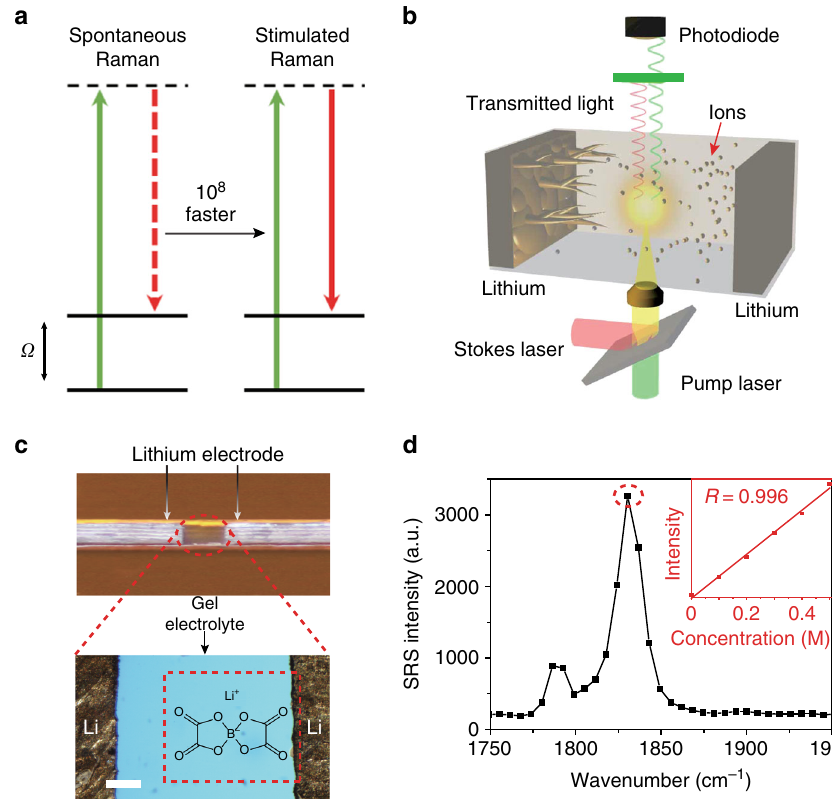
Fig. 1 Experimental principle and design. a Energy diagrams of spontaneous Raman scattering and stimulated Raman scattering (SRS). In spontaneous Raman, only one laser (green, solid line) is used, and the scattered photons (red, dashed line) will have an energy loss of Ω , corresponding to the vibrational energy of the targeted bond. In SRS, two different lasers (green/red, solid line) with energy gaps matching Ω are simultaneously used and yield up to 10 8 times faster vibrational transitions. b A schematic illustration of a Li – Li symmetric cell under SRS imaging. The two lasers are the pump laser and Stokes laser. c A camera image of a Li – Li symmetric cell (top) and zoom-in microscope image (bottom). Scale bar is 100 μ m. The red, dashed rectangle indicates the imaging area. The molecular structure is of the LiBOB salt used in our study. Scale bar is 100 μ m. d The SRS spectrum of 0.5 M LiBOB in TEGDME/PVdF-HFP gel electrolyte. The inset shows the linear concentration dependence between the Raman intensity at 1830 cm – 1 (dashed circle) and the LiBOB concentration from 0 M to 0.5 M